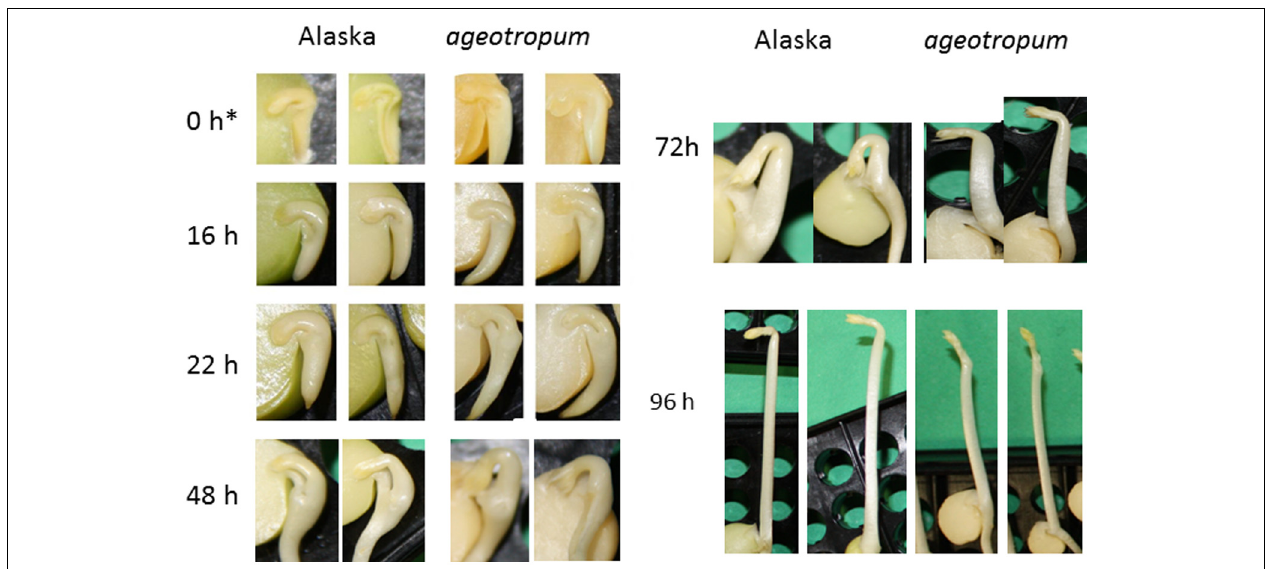
facilitate dissection. Although the epicotyl of ageotropum extended obliquely under 1- g conditions as well, the photos at 72 h and 96 h asw are arranged so that the epicotyl parallels that of Alaska for the convenience of comparing the hooks between the two varieties. Time is in h